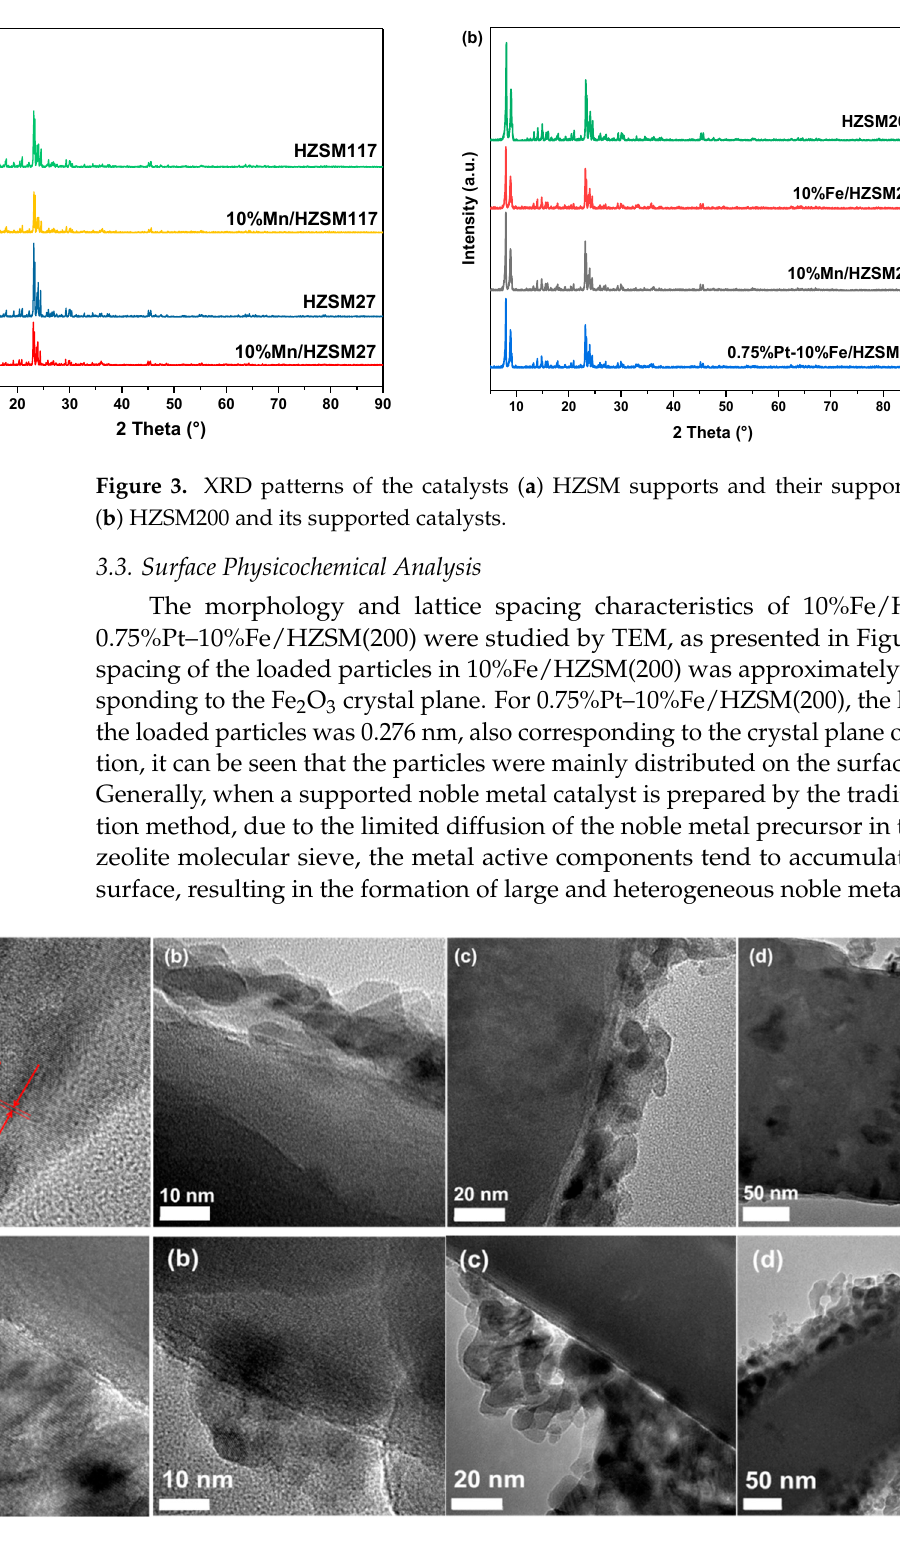
Figure 4. TEM images of 10%Fe/HZSM(200) (( a – d ) in top side) and 0.75%Pt–10%Fe/HZSM(200) (( a – d ) in the bottom side).